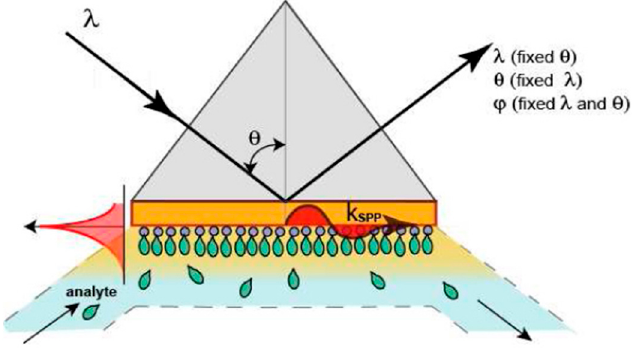
Figure 1. Interrogation modes for commercial surface plasmon resonance (SPR) instruments (reproduced from [30] with permission of OSA Publishing).